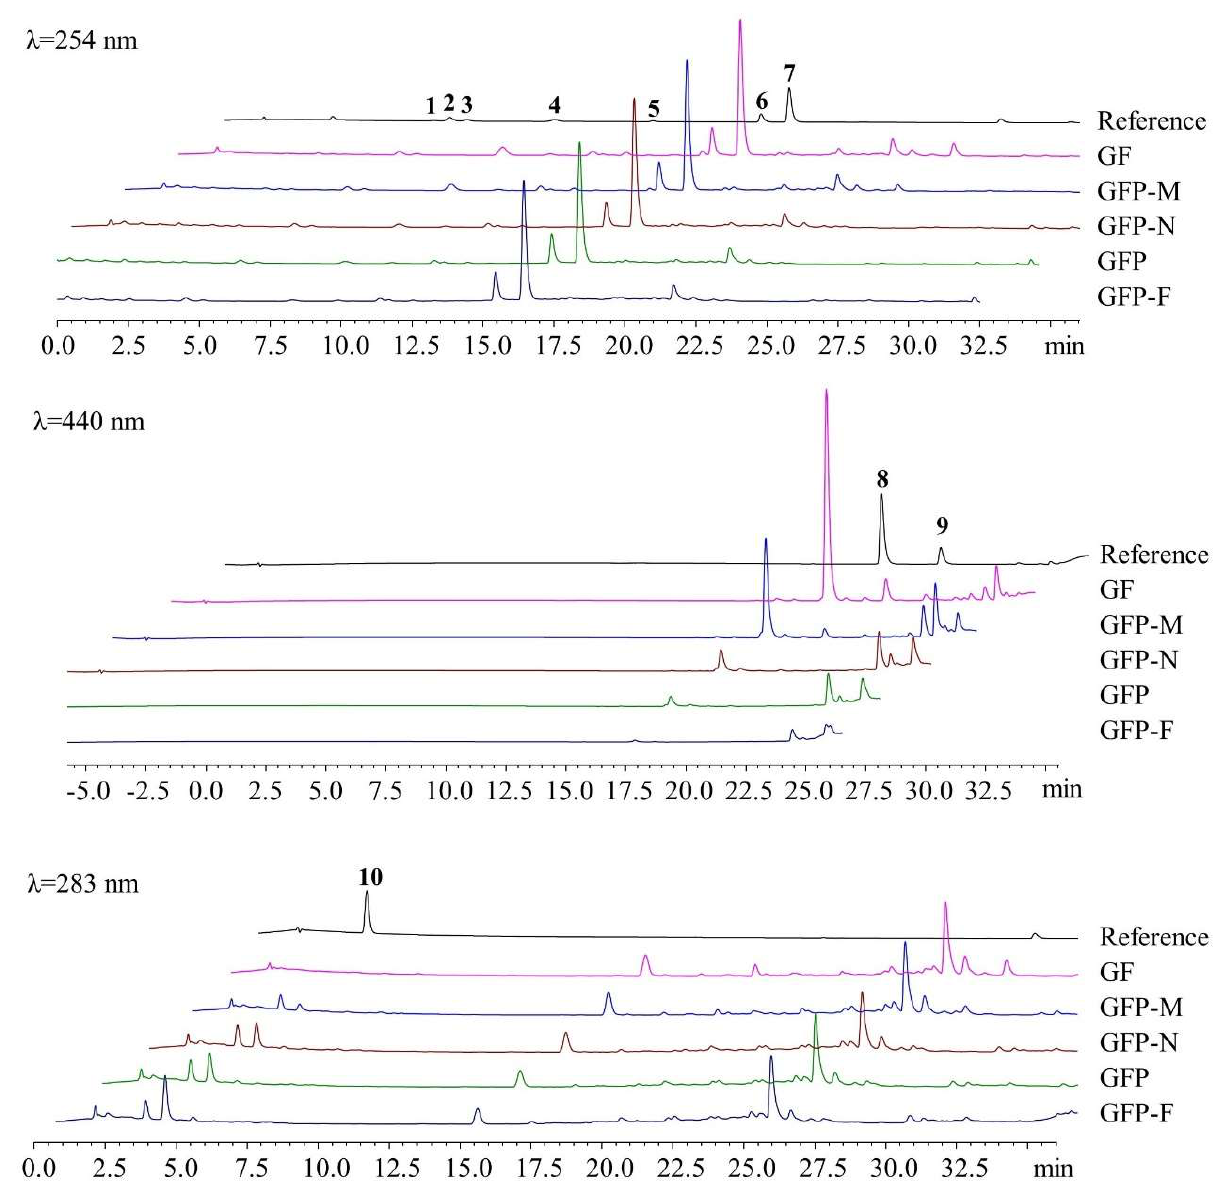
Figure 1. UPLC chromatogram of five GFP processed decoction pieces. 1—geniposidic acid; 2— shanzhiside; 3—deacetyl-asperulosidic acid methyl ester; 4—gardenoside; 5—scandosidemethyl ester; 6—G1; 7—G2; 8—C-I; 9—C-II; 10—5-HMF.